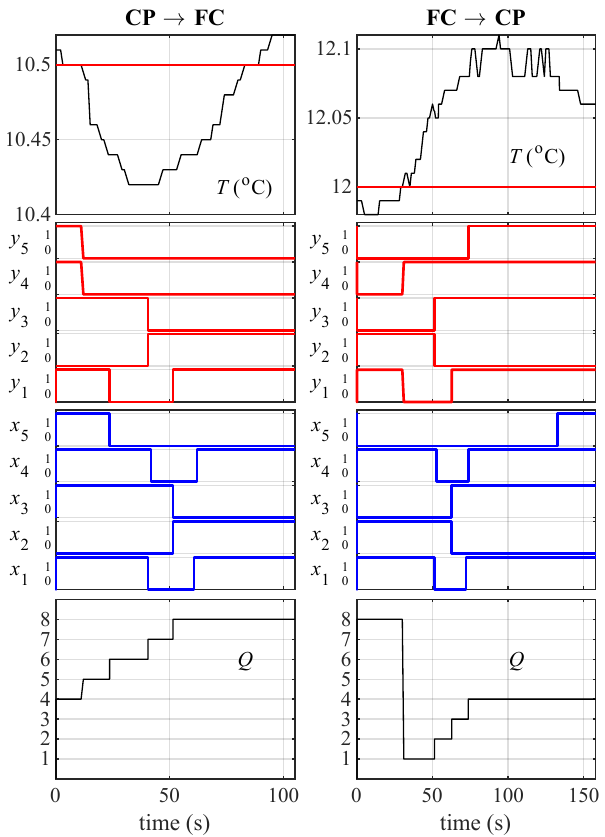
Figure 3. Transition between freecooling and compressor